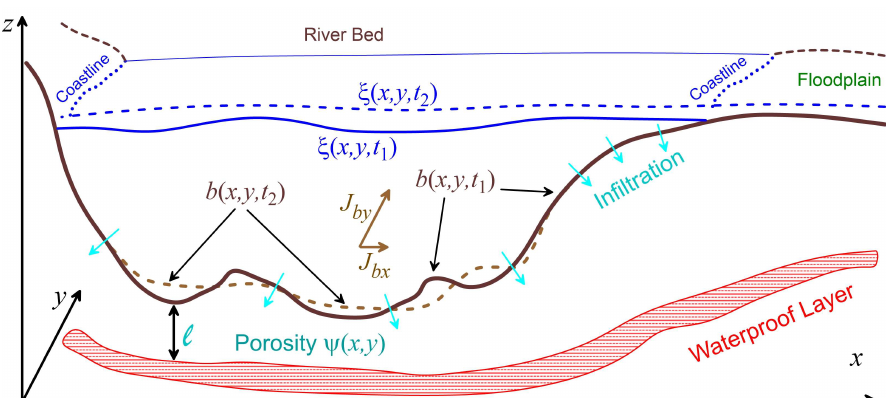
Figure 8. Geometric scheme of the three-layer model, including surface water, sediment and ground- water. The solid and dashed lines show the bottom profiles b for two different times t 1 and t 2 . The red color indicates the position of the waterproof layer, which is the groundwater